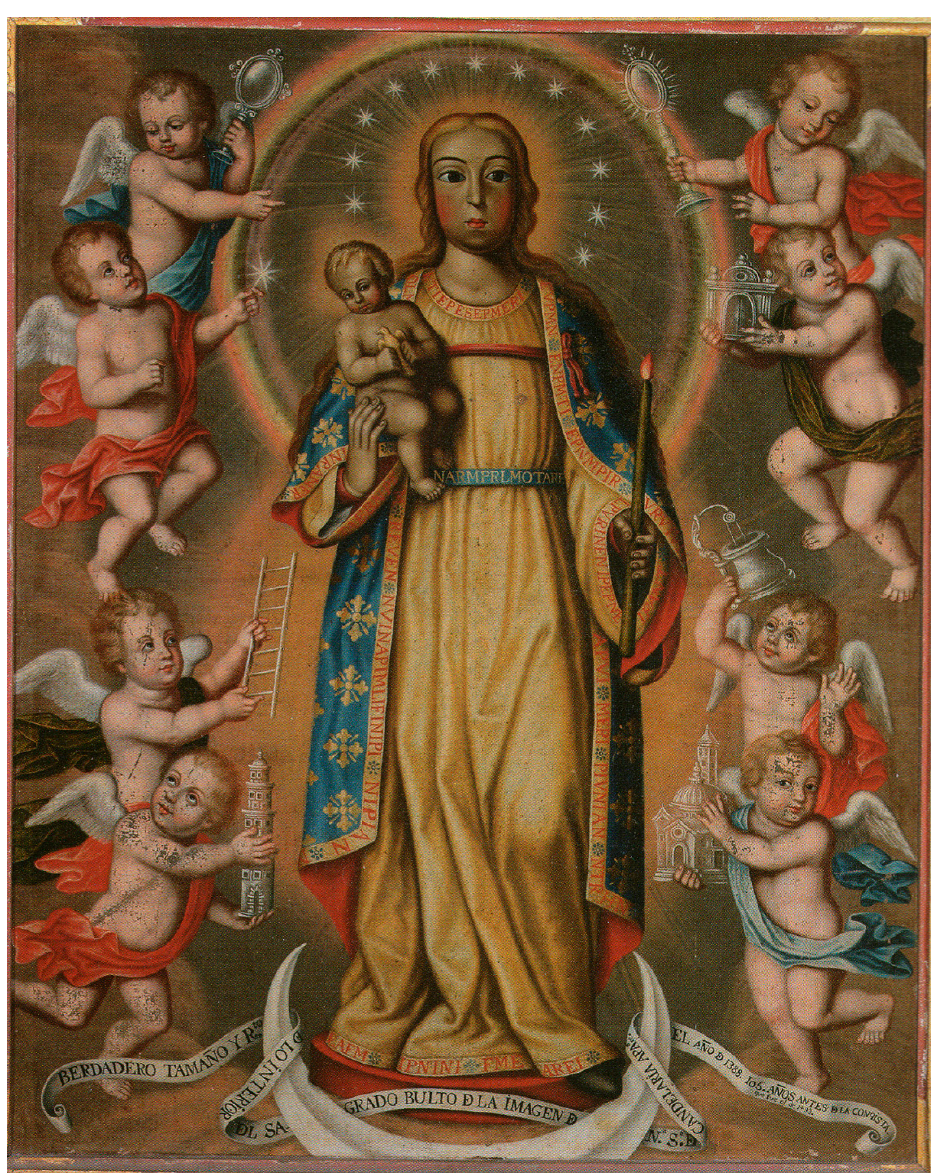
Figure 1. Virgin of Candelaria . ¿Nicolás de Medina Villavicencio? 1730–1750. Private collection (Tenerife) (Morales 2009).